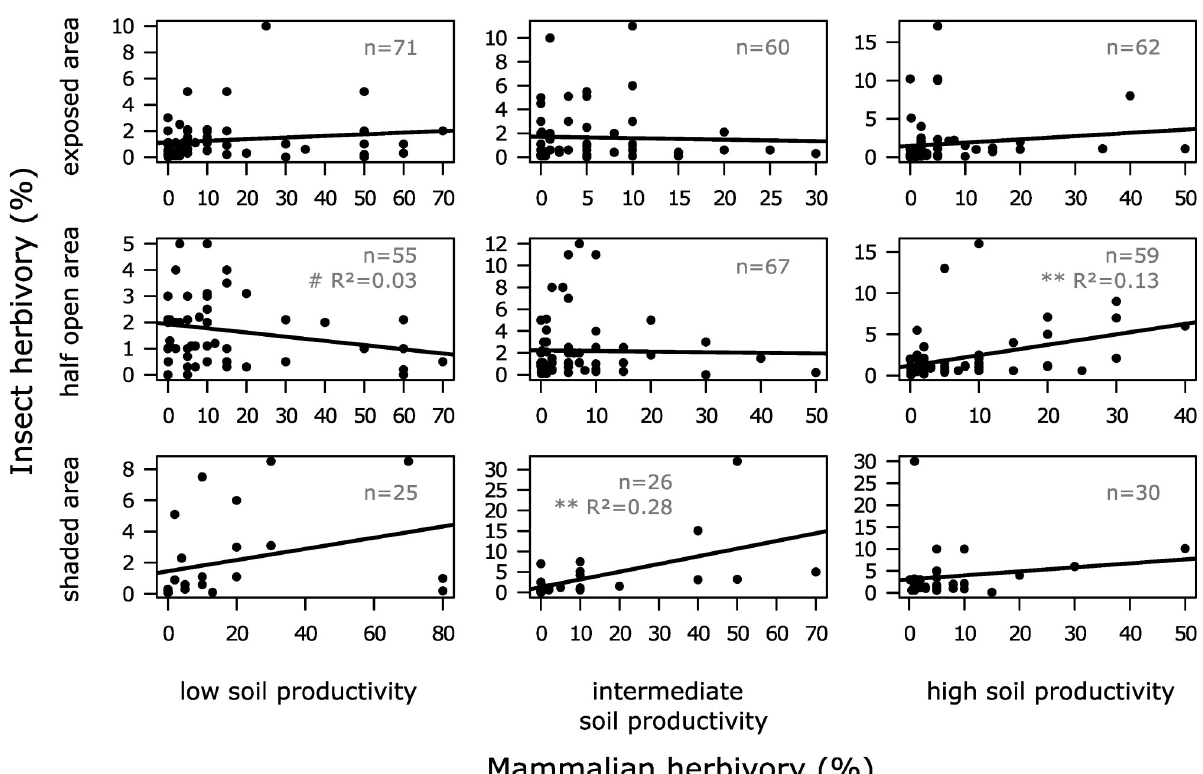
Fig 4. Observed insect versus mammalian herbivory on bilberry at different light availability and soil productivity levels. Insect herbivory versus previous mammalian herbivory on bilberry ( Vaccinium myrtillus ) in exposed areas (shade < 20%), half open areas (shade between 20% and 80%) and shaded areas ( > 80% shade) and at low, intermediate and high soil productivity levels. In each panel the number of observations (n) is given, and the P -value (ANOVA) for the linear regression (regression line shown in each panel) is indicated as: ��� 0 < P < 0.001; �� 0.001 < P < 0.01; � 0.01 < P < 0.05; # 0.05 < P < 0.10; blank P > 0.10. If P < 0.10 the adjusted R-squared value is given.